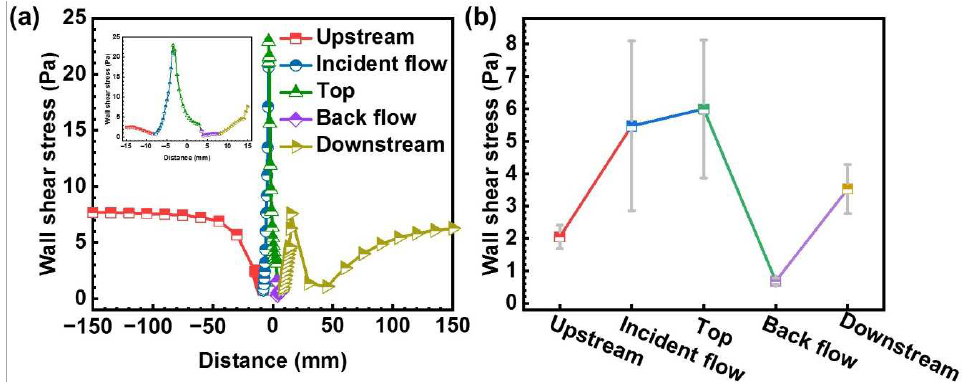
Figure 15. ( a ) Variations of the WSS on the samples at different positions in the flow direction and ( b ) average WSS of samples in different surfaces of the WRH at the condition of the main flow velocity of 2.3 m/s.